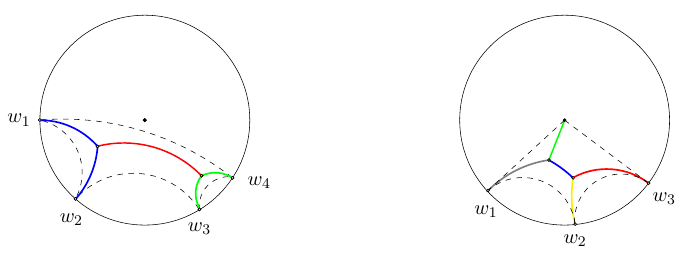
Figure 7 . Two types of N = 4 holographic Steiner trees: (a) ideal holographic Steiner tree, this is the hyperbolic analog of the graph (b) on (cid:12)gure 1, (b) non-ideal holographic Steiner tree. Cutting the bridge (blue inner edge) yields the disconnected graph (a) on (cid:12)gure 5, see section 2.4. The associated hyperbolic 4-gons are shown in dashed Figure 5 . N=4 tree with four points on the boundary.